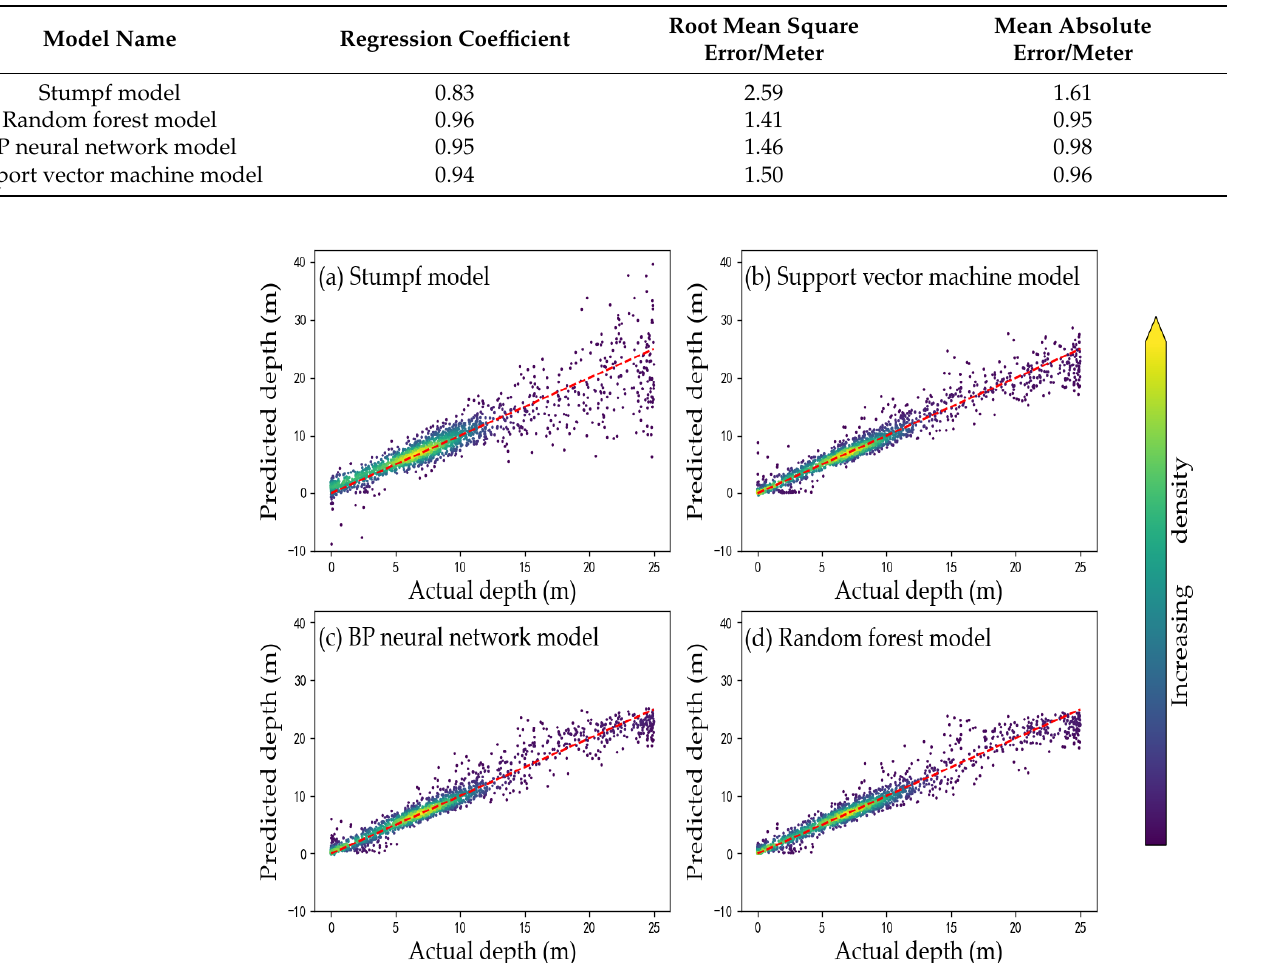
Table 3. Overall accuracy of the models.